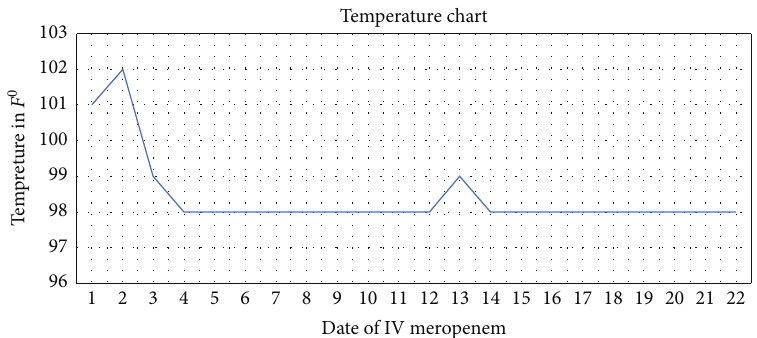
Figure 3: Temperature distribution throughout hospital